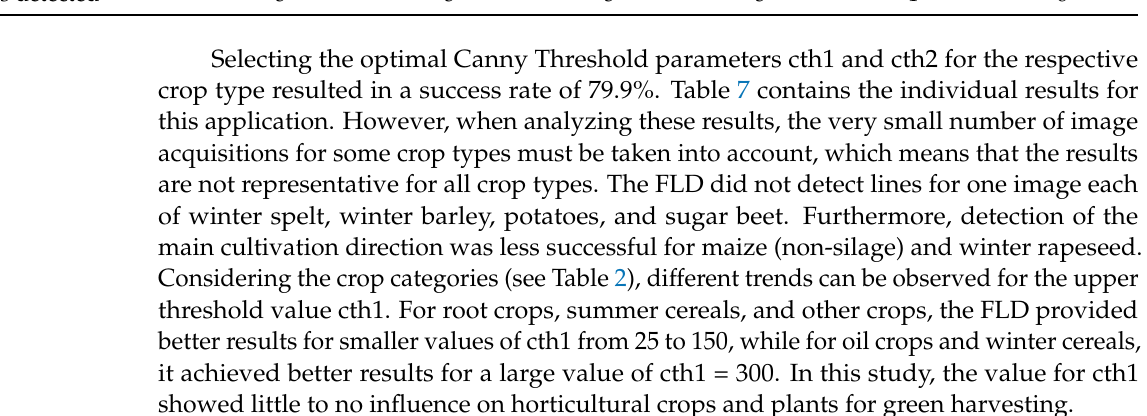
Table 7. Best results of FLD with individual adjusted Canny Threshold parameters for each crop type; data source: [40]. Crop Type